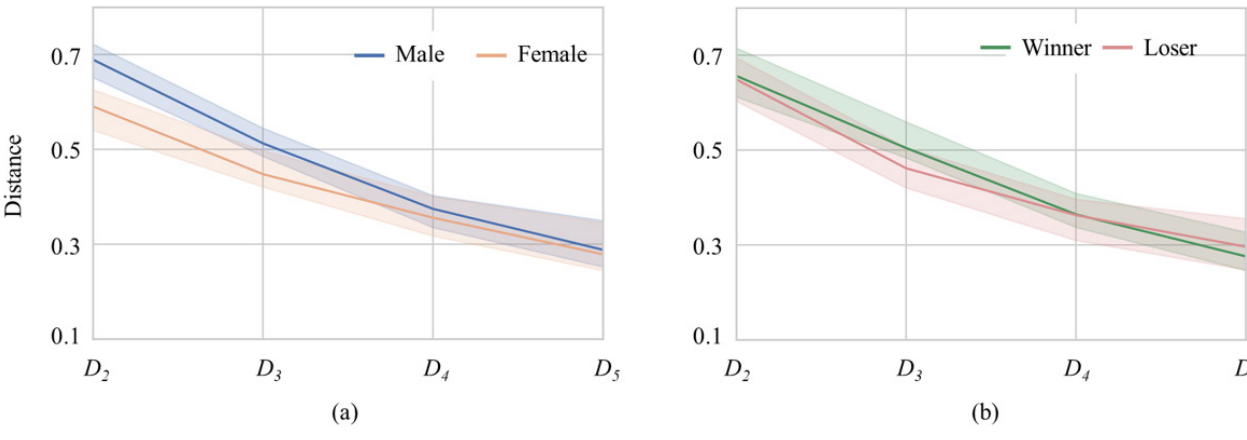
, the distributional distance at i-th i